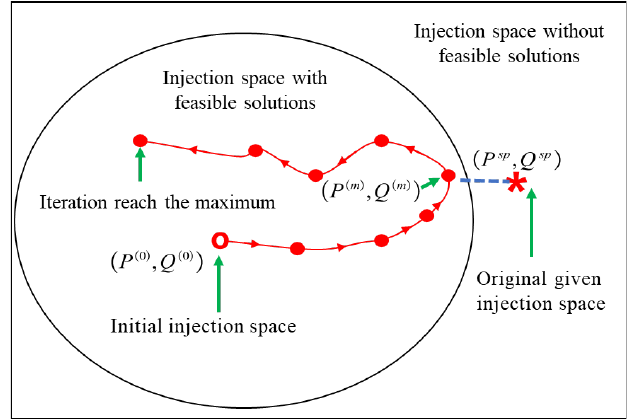
Figure 1. The evolution of the injection space of the intermediate power flow during the iteration process.